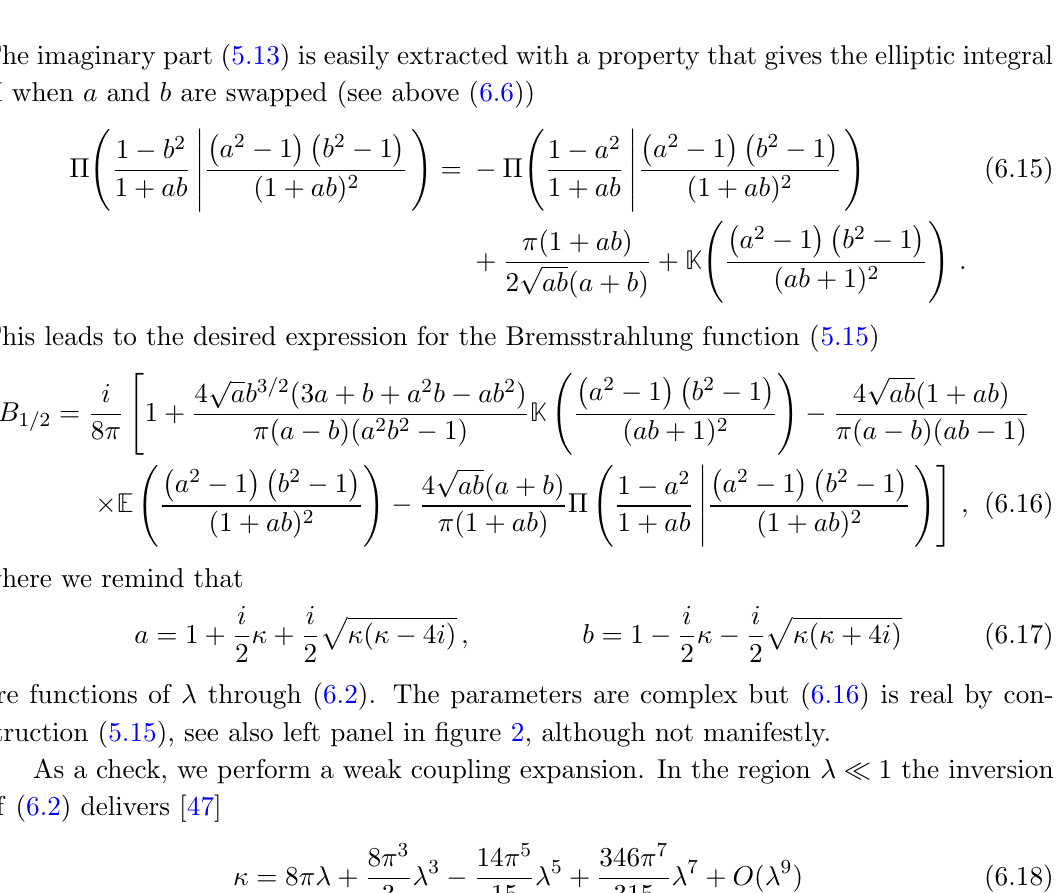
Figure 2 . Left panel: plot of (6.16) (black curve) and its weak/strong coupling expansions (6.19) and (6.22) (blue/red curves) as functions of the ’t Hooft coupling. Right panel: plot of (6.16) as function of the interpolating function of ABJM